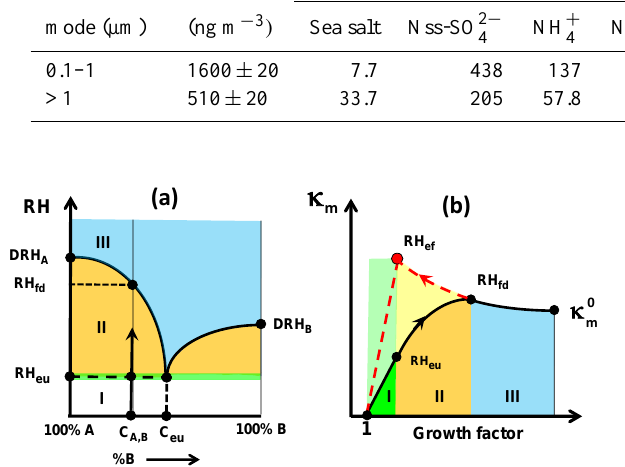
Figure 3. An illustrative example of KIM assuming a two- component mixture (A, B): (a) – phase diagram; (b) – the respective variation of the hygroscopicity, κ m , due to water uptake. The light colored areas are responsible for the metastable state of the solution. Explanation and designations are given in the